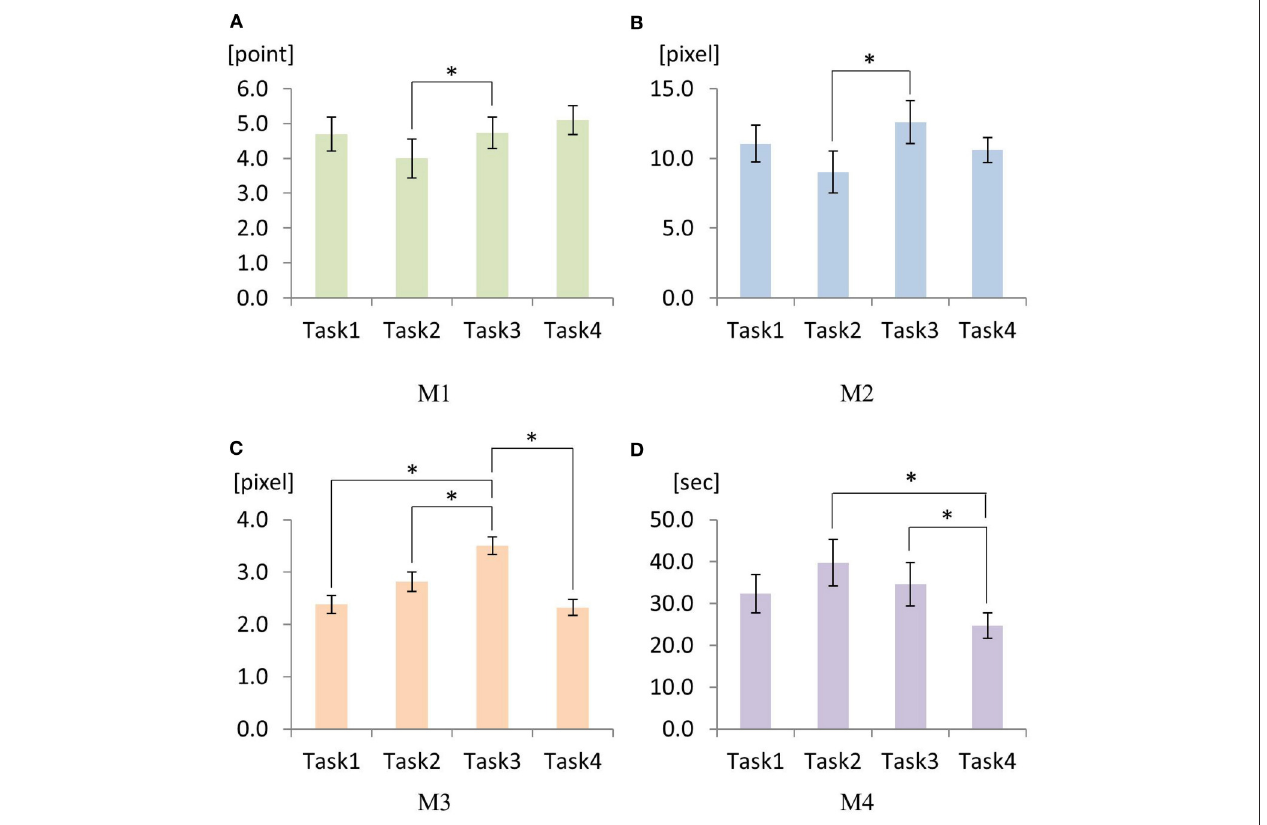
FIGURE 12 | Mean values for M1 (A) through M4 (D) under four task scenarios: Task1, Task2, Task3, and Task4. An error bar represents standard error. Significances are indicated by “ * ” for p < 0.05 resulted from Bonferroni adjusted pairwise comparisons.